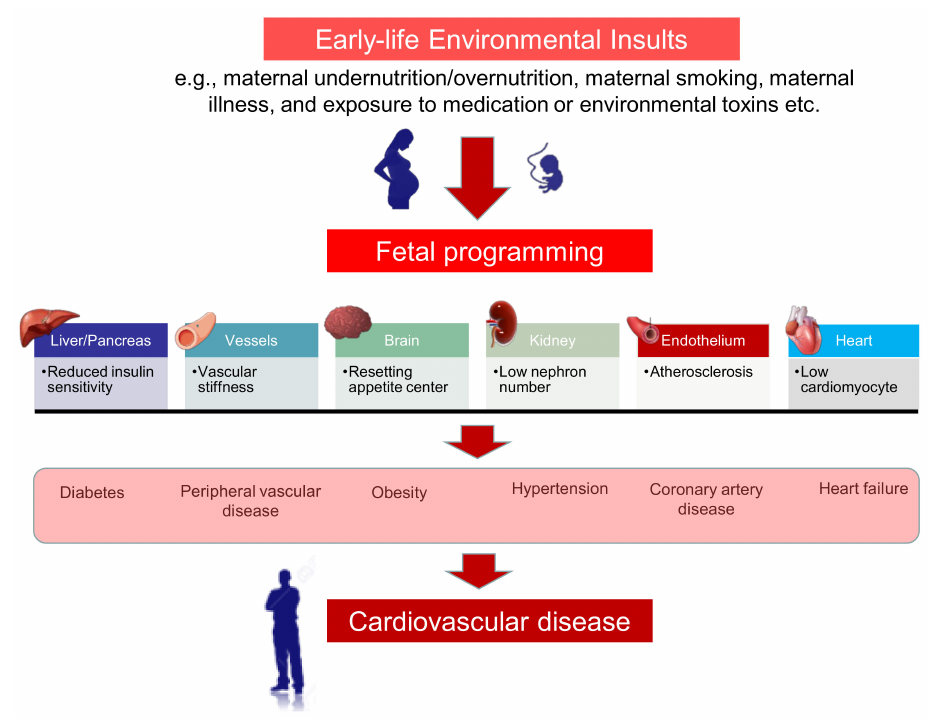
Figure 2. Schematic illustration of links between maternal insults, fetal programming, and cardio- vascular disease of developmental origins. A wide range of early-life environmental factors can influence fetal programming, include maternal undernutrition/overnutrition, maternal smoking, maternal illness, and exposure to medication or environmental toxins. During organogenesis, these maternal insults induce morphological and functional changes in different organ systems, such as liver, pancreas, heart, vessels, brain, kidney, and endothelium. Consequently, cardiovascular programming causes a cluster of phenotypes such as diabetes, hypertension, obesity, dyslipidemia, type 2 diabetes, and cardiovascular morbidity, all risks factor for cardiovascular